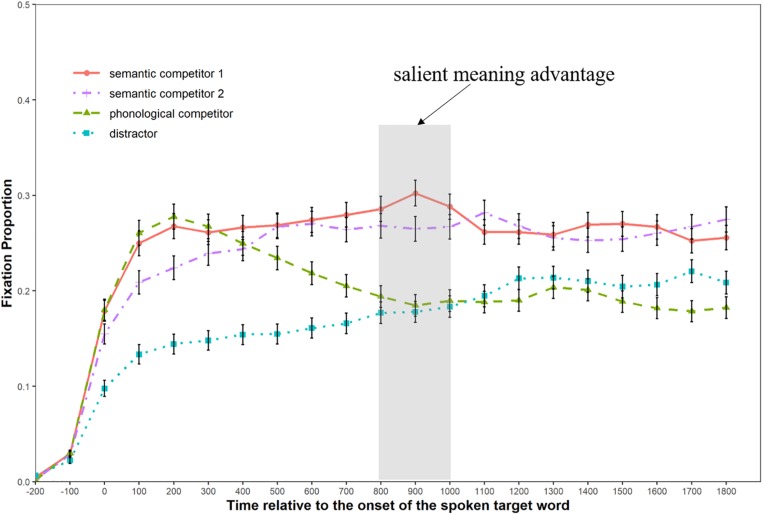
Graph showing the fixation patterns in the pun condition.